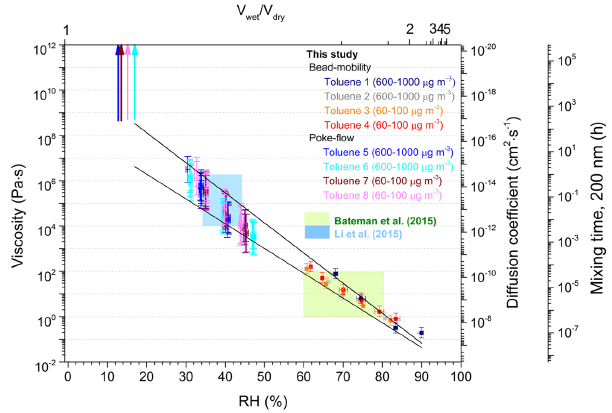
Figure 5. Viscosities of toluene-derived SOM particles as a func- tion of RH. For RH > 60% the viscosities were determined from the mean bead speeds (see Fig. 3) and a calibration line (Song et al., 2015). The y error bars for RH > 60% represent the 95% predic- tion intervals from the calibration line. For RH < 60% the viscosi- ties were calculated from the τ exp, flow where y error bars represent the calculated lower and upper limits of viscosity using the simu- lations. The x error bars over the entire range of RH represent the range of RH values in a given experiments and the uncertainty in the RH measurements. The right y axes present calculated diffusion co- efficients of organic molecules in SOM using the Stokes–Einstein relation, and calculated mixing times within 200nm particles due to bulk diffusion using Eq. (2). The black lines represent linear fits for the RH vs. log(lower viscosities) ( R 2 = 0 . 958) and log(upper viscosities) ( R 2 = 0 . 984) from the entire data set excluding the RH where particles cracked. Viscosity of toluene-derived SOM parti- cles from Bateman et al. (2015) (green box) and Li et al. (2015) (blue box) is also included. The secondary x axis shows V wet /V dry of the SOM, where V dry is the volume of SOM at 0%RH and V wet is the volume of the SOM after taking up water at a given